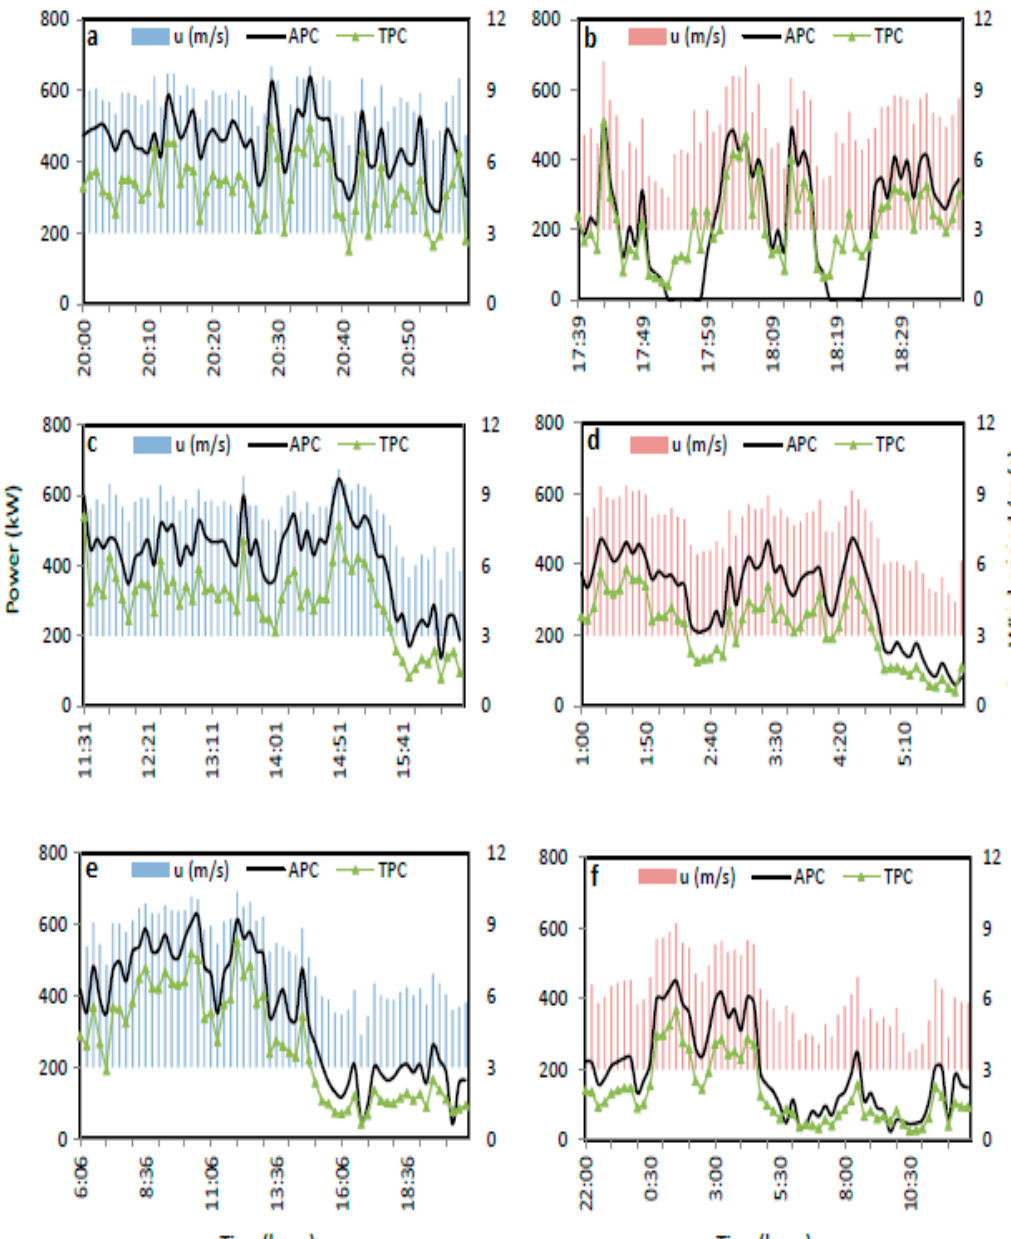
Figure 1. Turbine actual and theoretical power output during scenario A for: 1-min time intervals in ( a ) winter and ( b ) summer; 5-min time intervals in ( c ) winter and ( d ) summer; and 15-min time intervals in ( e ) winter and ( f ) summer, with average wind speed bars inset.